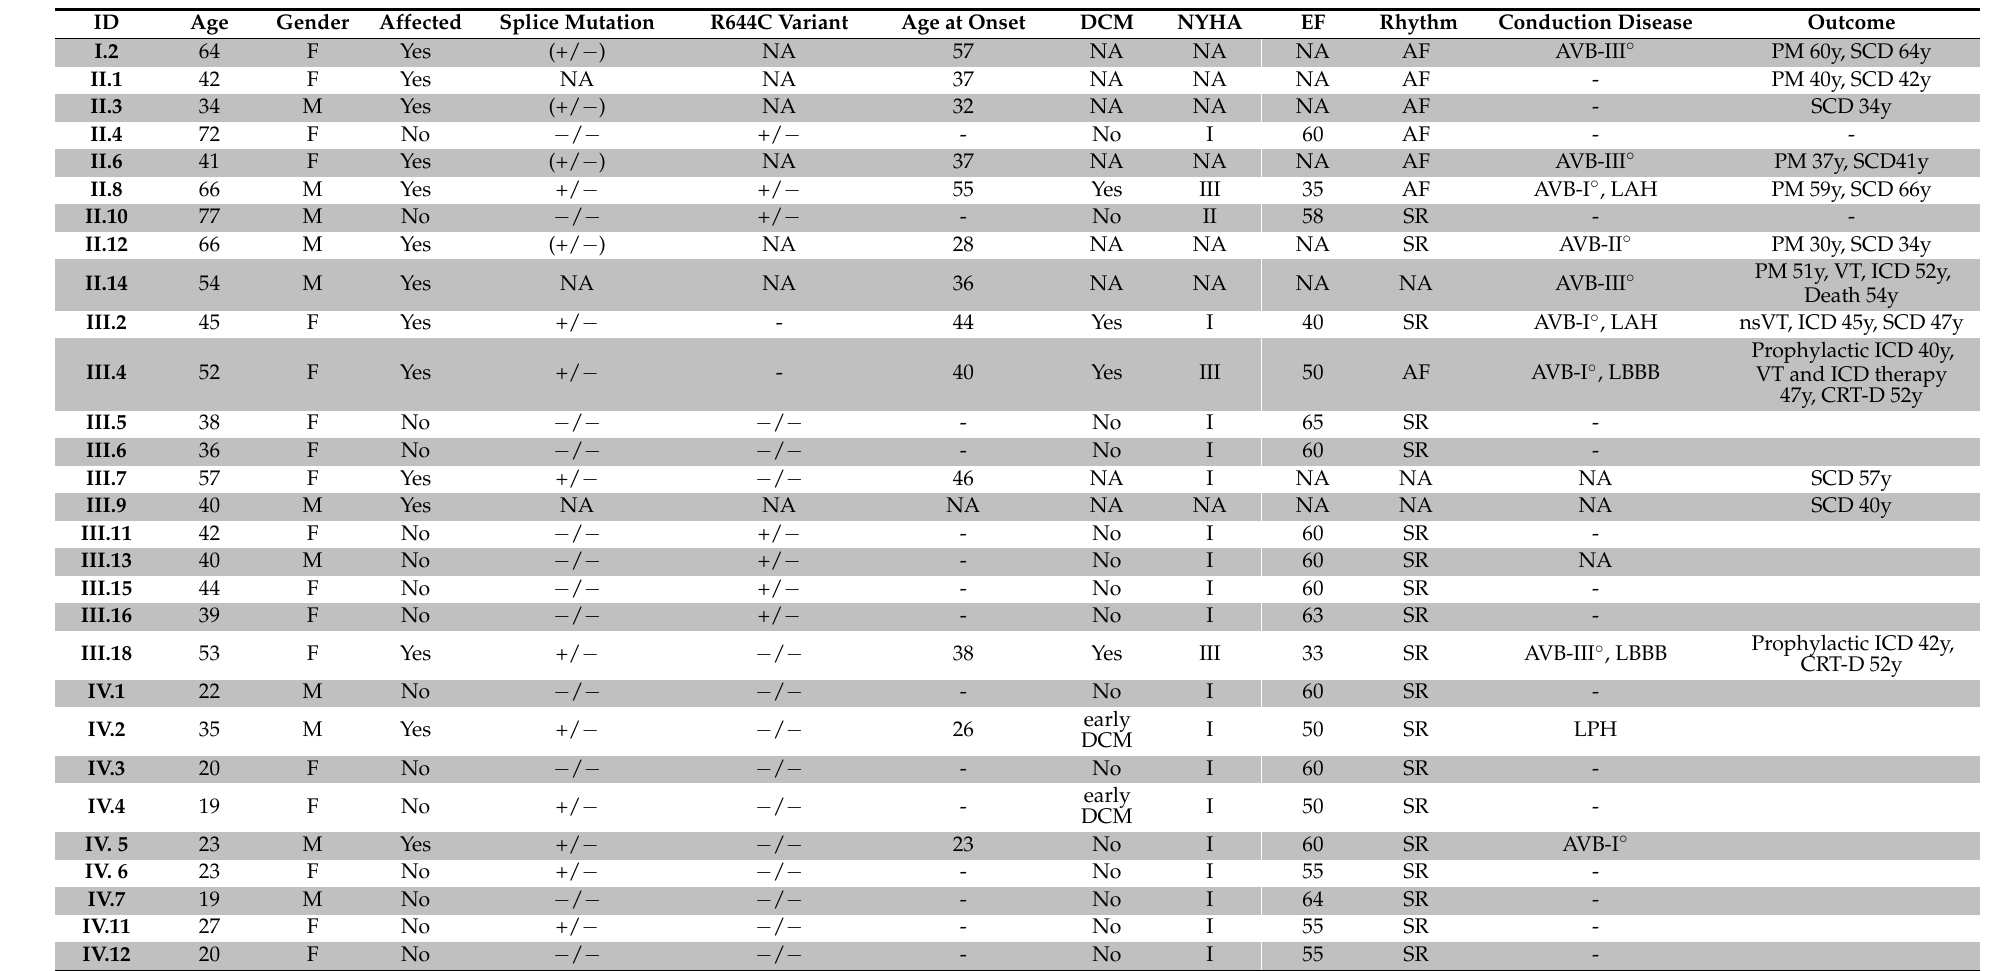
Table 1. Clinical characteristics of the family